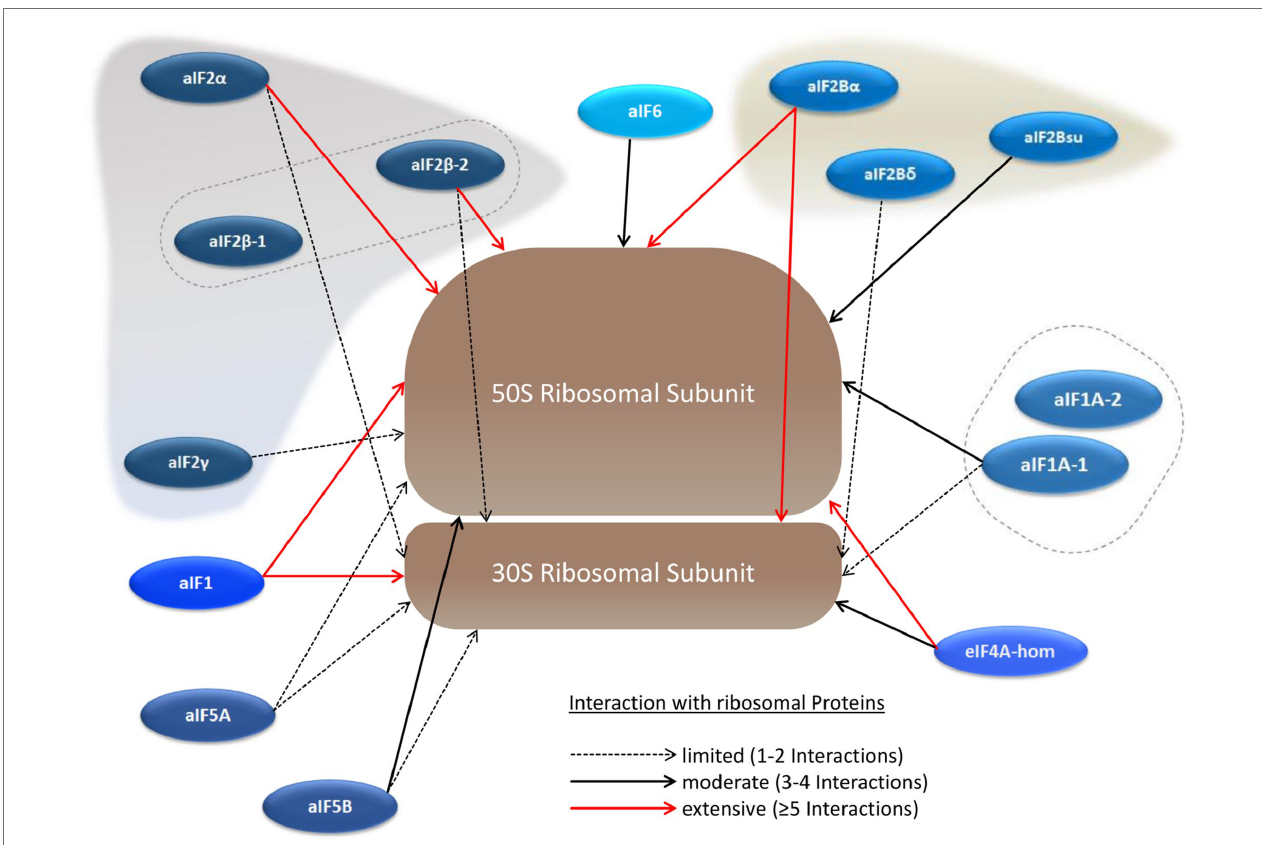
FIGURE 5 | Schematic overview of the aIF–ribosome interaction network. The large and the small ribosomal subunits are shown schematically instead of including all ribosomal proteins individually. The numbers of co-purified ribosomal proteins are indicated by red arrows (at least 5 co-purified proteins), solid black arrows (3–4 co-purified proteins), and dotted black arrows (1–2 co-purified